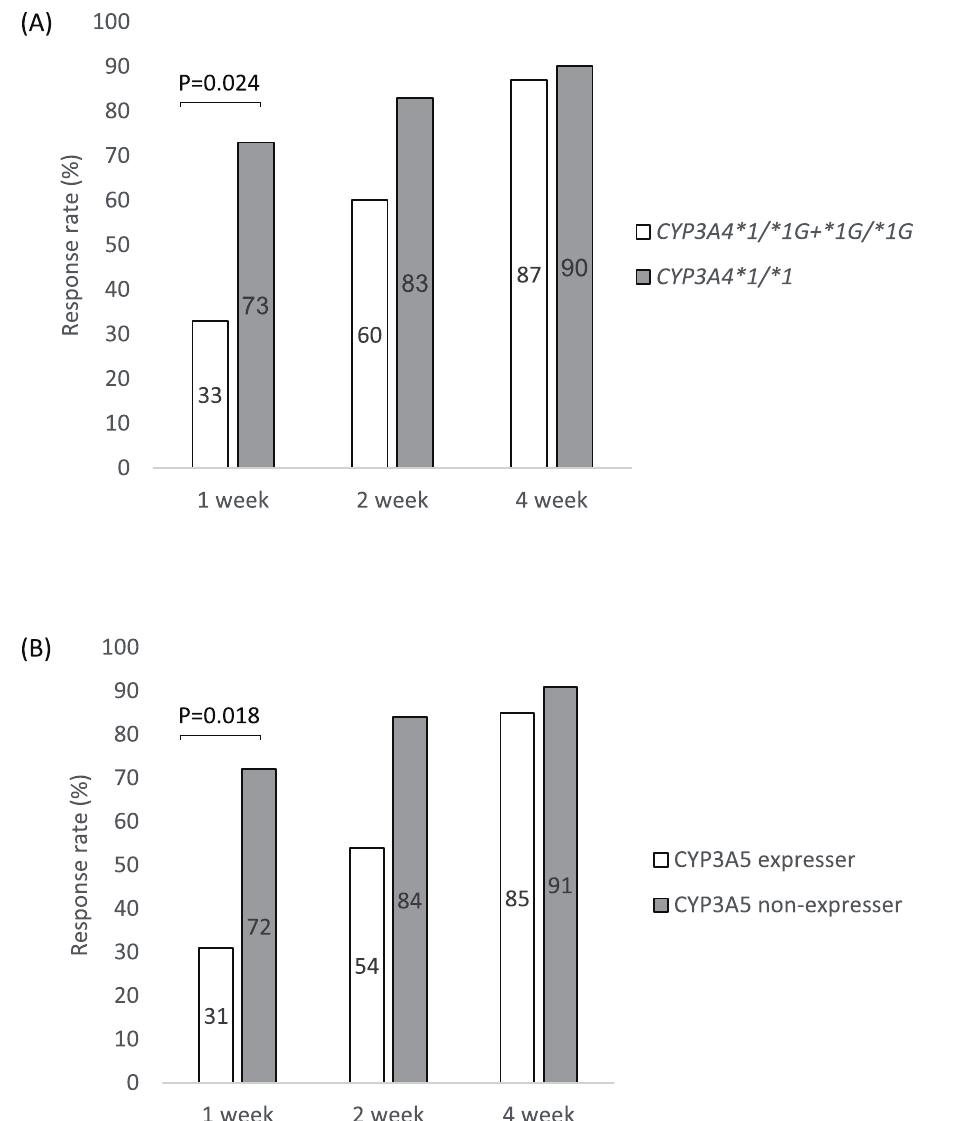
Fig 1. Response rate of patients with CYP3A4 and CYP3A5 polymorphisms after tacrolimus initiation. Panel A shows the response rate of patients with CYP3A4 polymorphisms at 1, 2, and 4 weeks after Tac treatment, and panel B shows that of patients with CYP3A5 polymorphisms. Clinical response was defined as a partial Mayo score reduction of � 2 points accompanied by a decrease of at least 30% from baseline and a decrease in the rectal bleeding subscore of � 1 or an absolute rectal bleeding subscore of 0 or 1. CYP3A4: cytochrome P450 family 2 subfamily A member 4; CYP3A5: cytochrome P450 family 2 subfamily A member